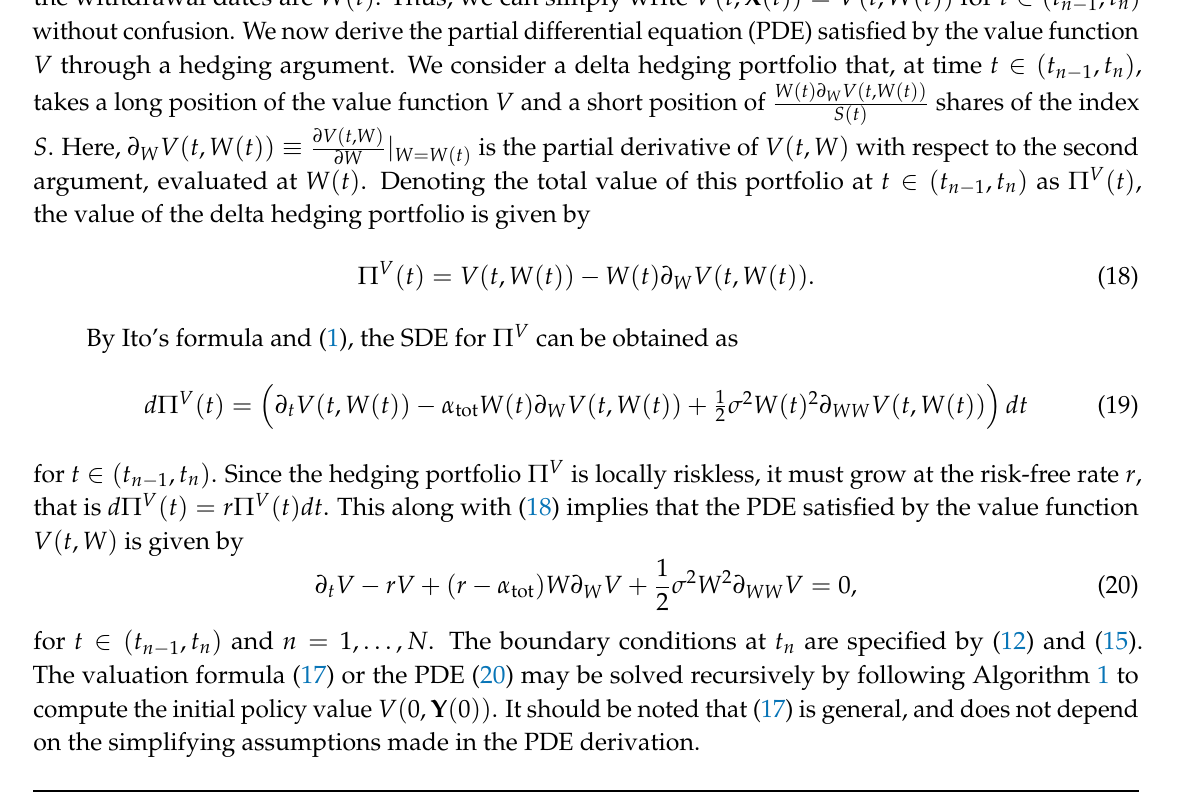
Algorithm 1 Recursive computation of V ( 0, X ( 0